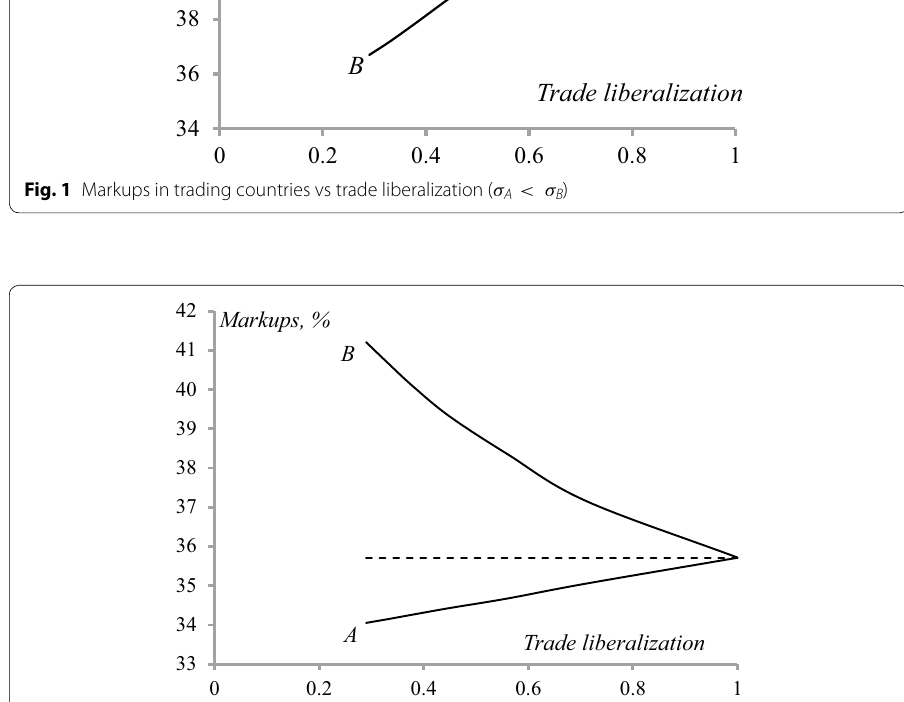
Fig. 2 Markups in trading countries vs trade liberalization ( σ A > σ B